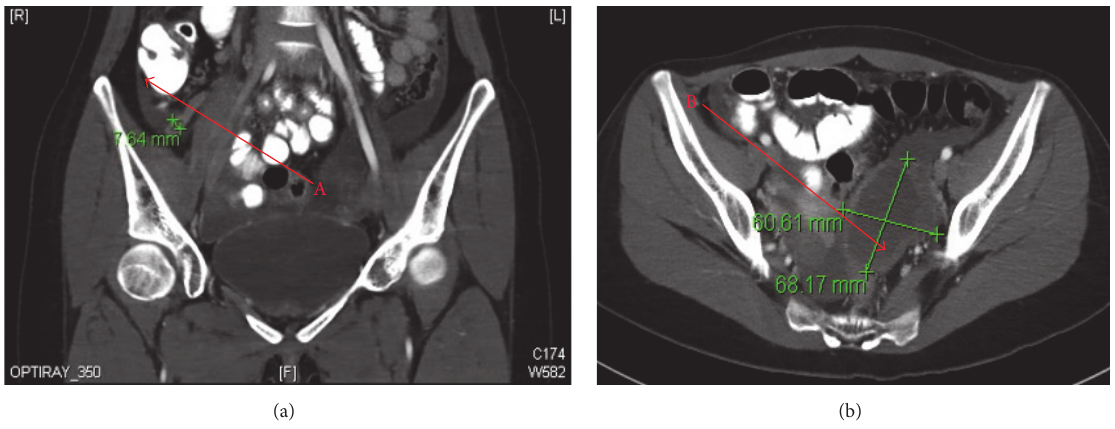
Figure 1: CT scan. A: inflamed appendix; B: left adnexal mass.